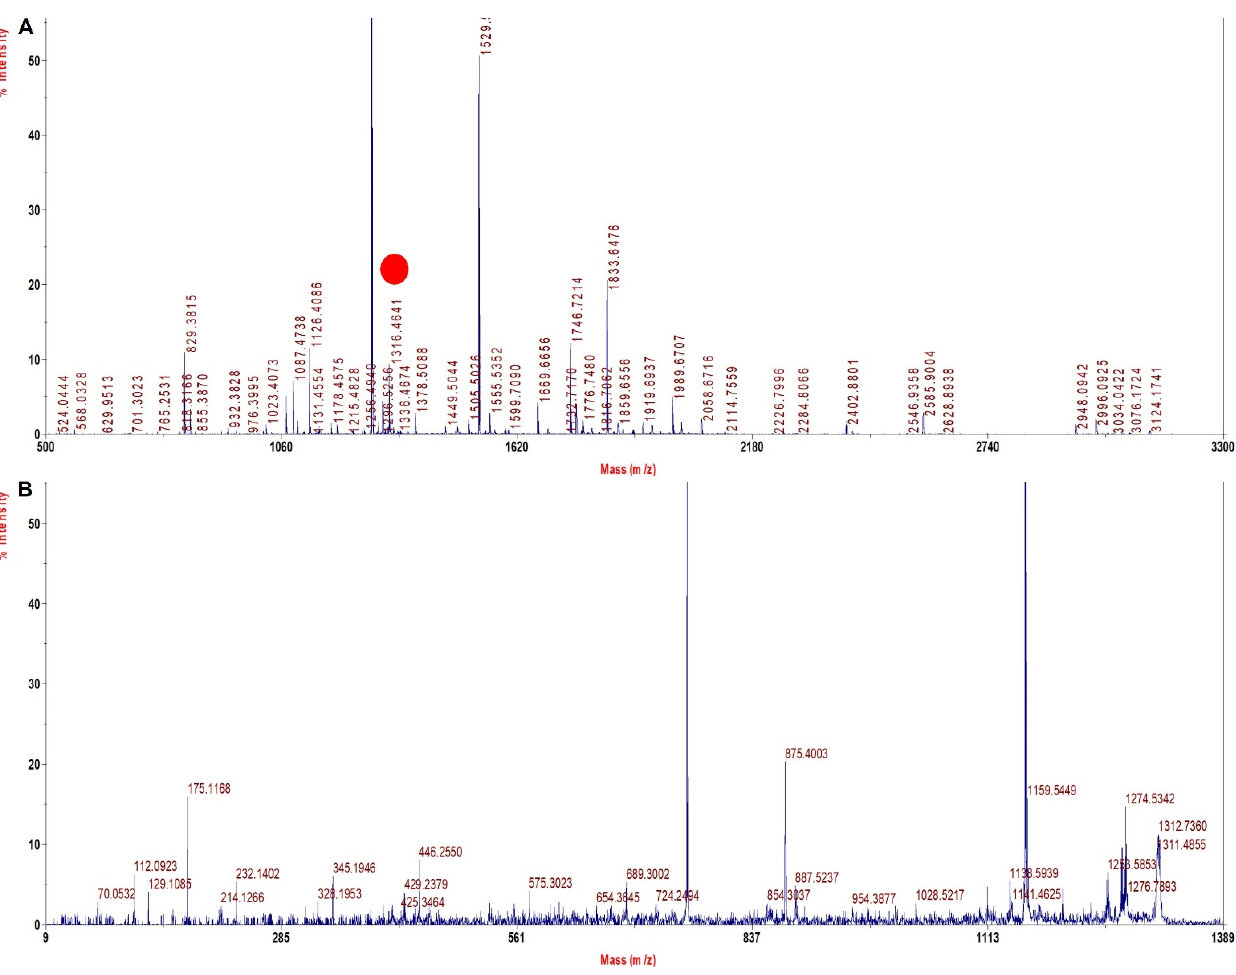
Table 5. Summarized mass spectrometric data for rHb mutants and Hb variants.